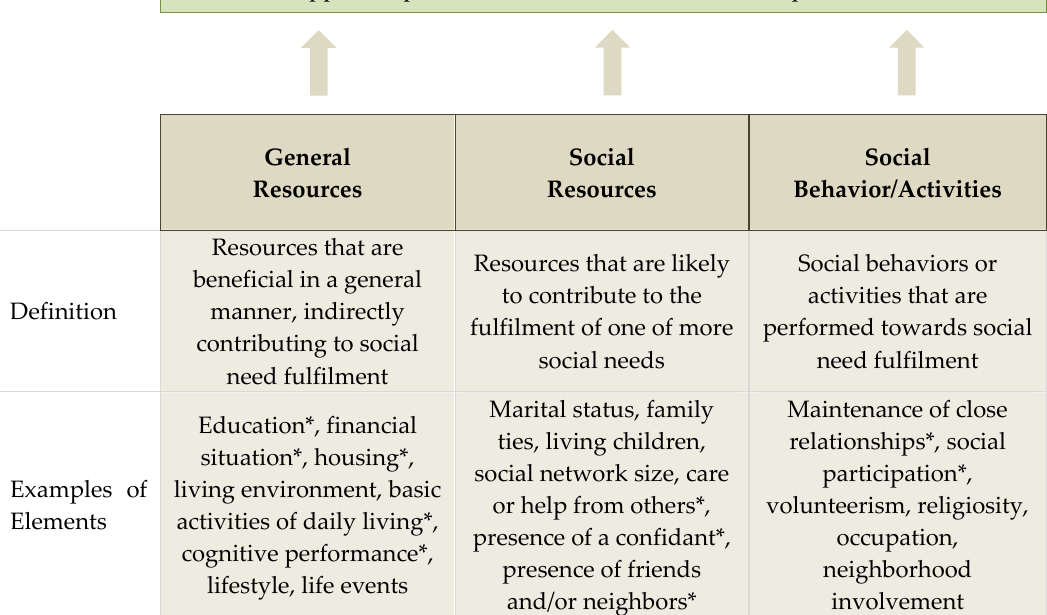
social participation, and environments. Prior Asian studies examining the impact of social frailty have done so using brief questionnaires of 5–7 items which are primarily modeled after the 5-item